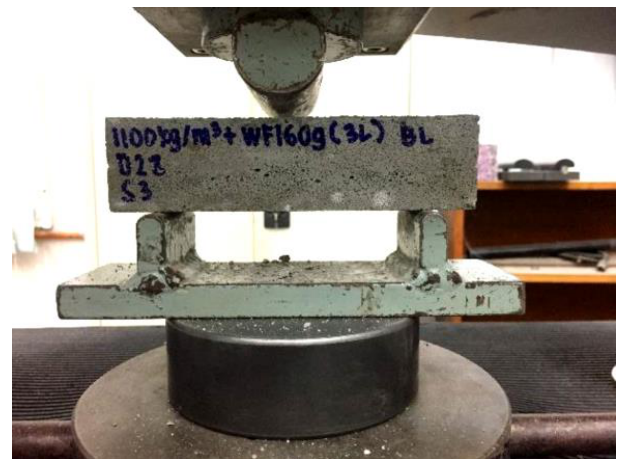
Figure 5. Setup for the flexural test.